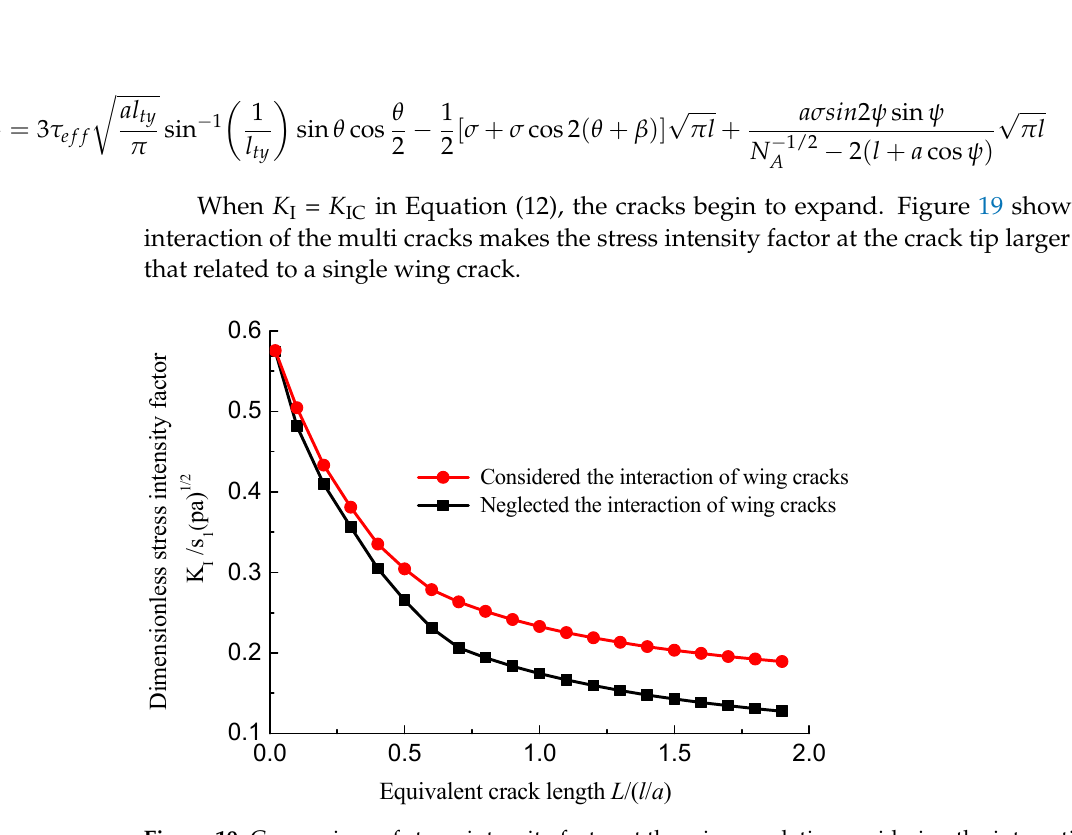
Figure 19. Comparison of stress intensity factor at the wing crack tip considering the interaction of multiple wing cracks.